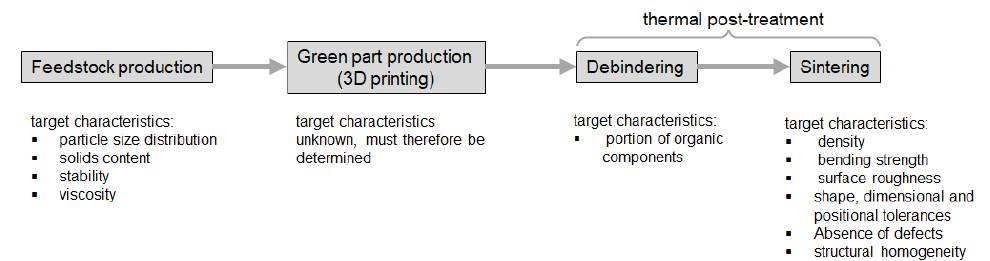
Figure 1. Flow chart of the multi-material jetting (CerAM MMJ) process chain.